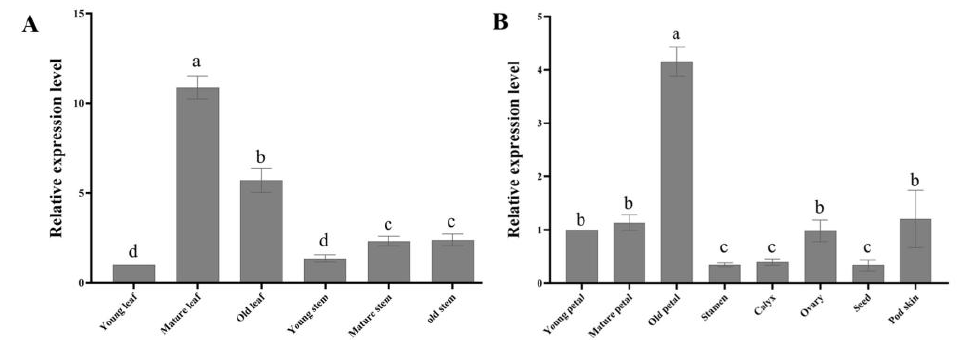
Figure 6. Relative expression analysis of PoLACS4 gene from different organs. ( A ) young leaf, mature leaf, old leaf, young stem, mature stem, and old stem; ( B ) young petal, mature petal, old petal, sta- ovary, calyx, seeds, and pod skin. men, ovary, calyx, seeds, and pod skin.